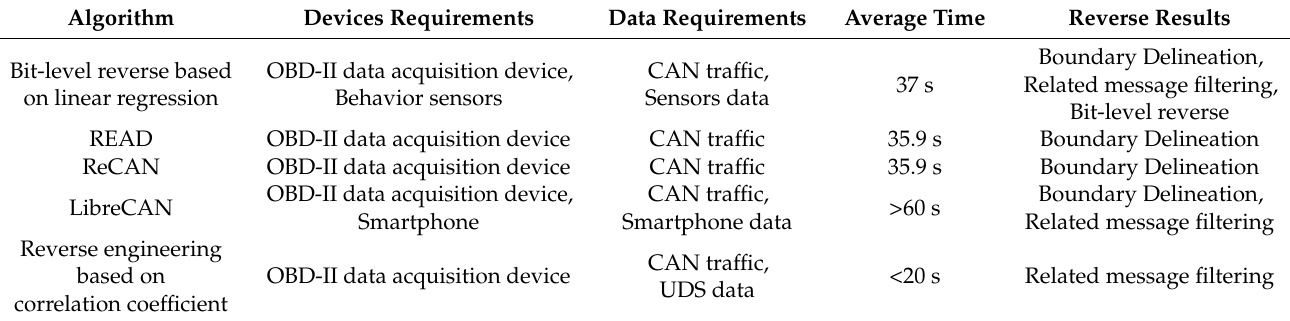
Table 12. Execution complexity comparison of different